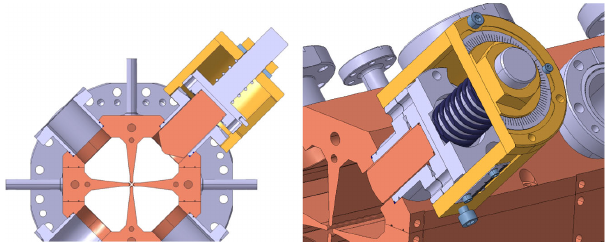
FIG. 3. Cross sections of the tuner tooling. The drawing shows the tuner itself, the mounted thread for adjustment of the penetration depth and the tube that attaches the tuner tooling to the flange.